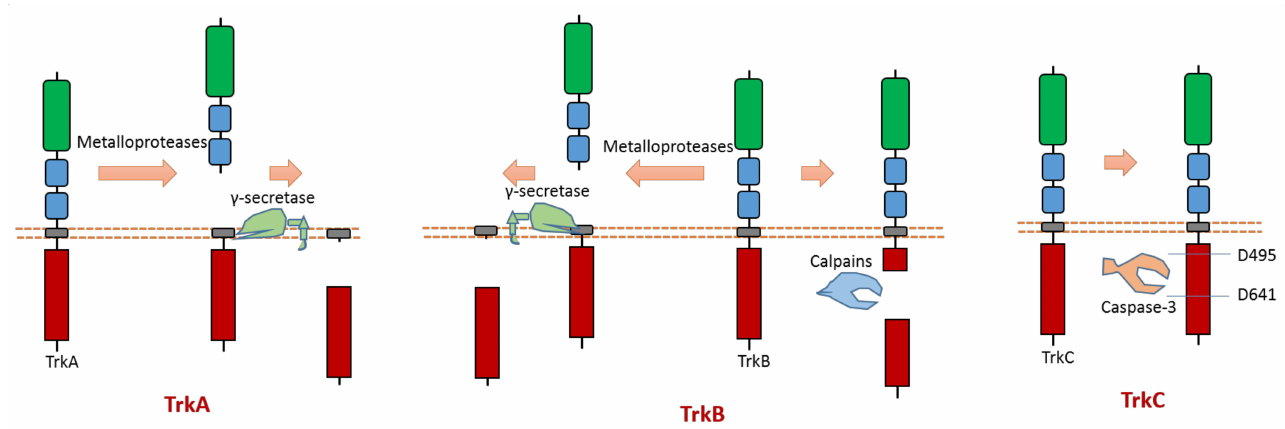
Figure 5. Schematic illustration of proteolytic cleavage in members of Trk